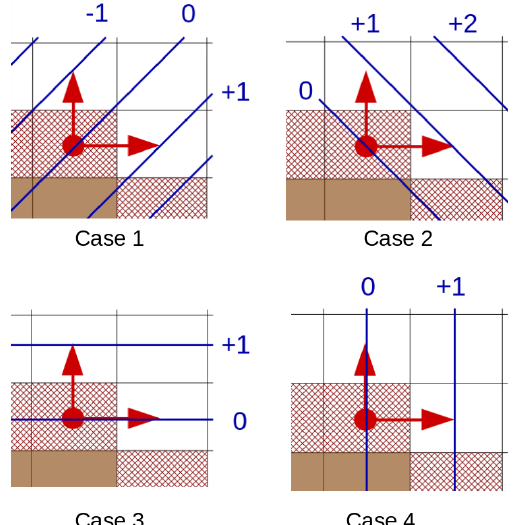
Figure 6. Brown cells are land cells and red hatched cells are open boundary cells. Red dots mark points from the open boundary and red arrows the best points to use to compute the Neumann condition, blue lines are contour lines of φ with the value of the contour line highlighted in blue.